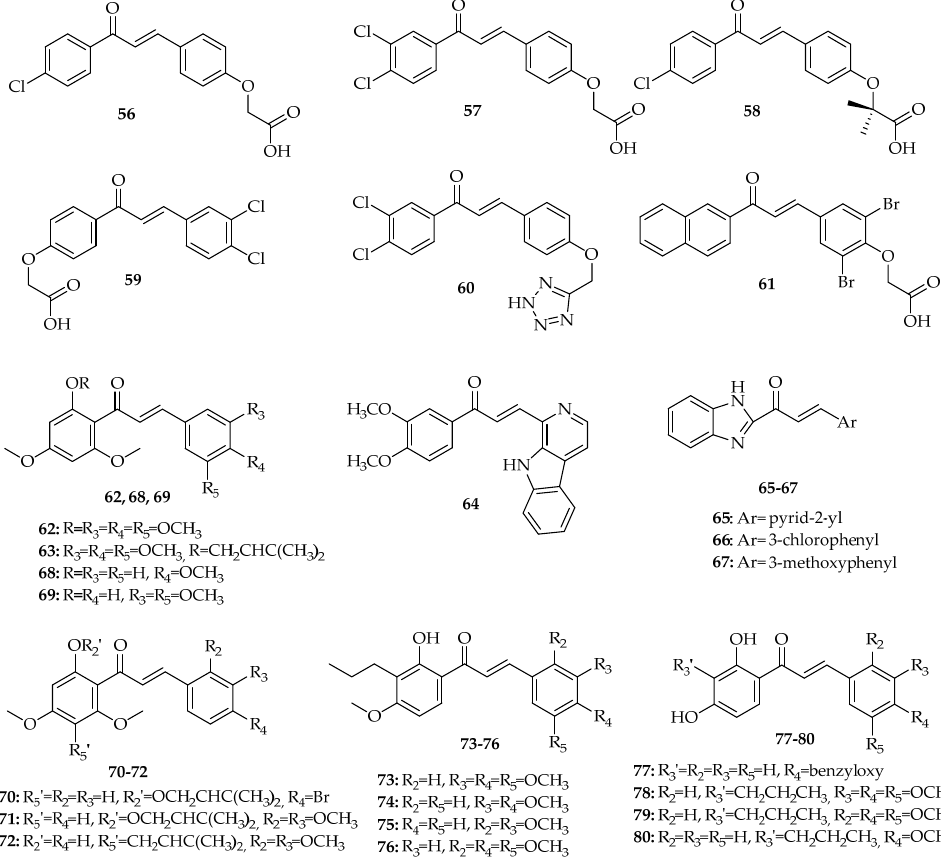
Figure 8. Structures of chalcones 56 – 80 .